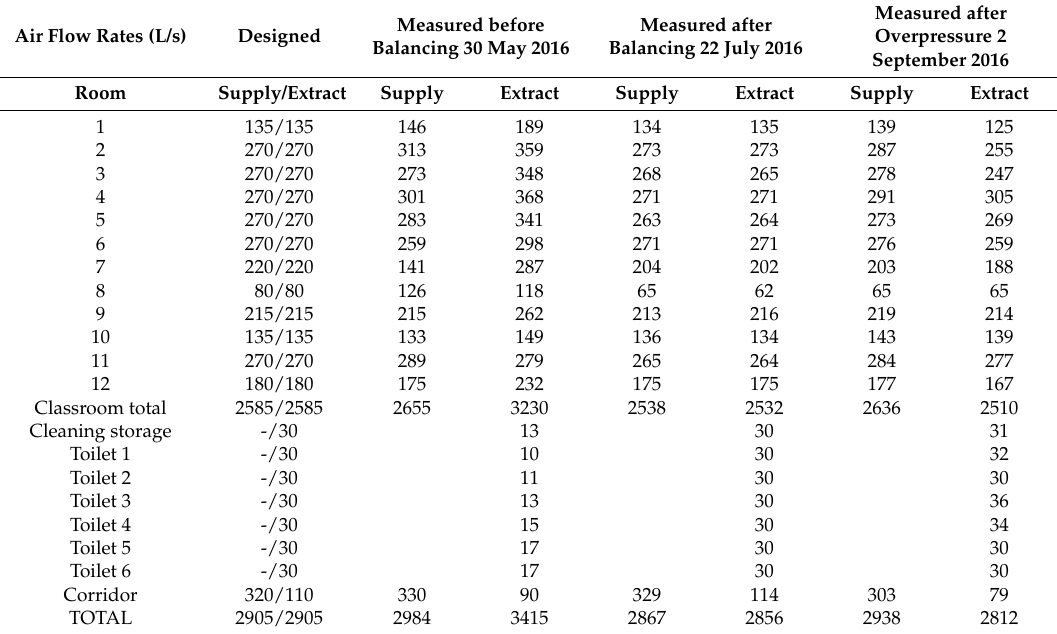
Table 3. Supply and extract airflow rates of the studied building section before ventilation balancing, after balancing, and after generating positive pressure.